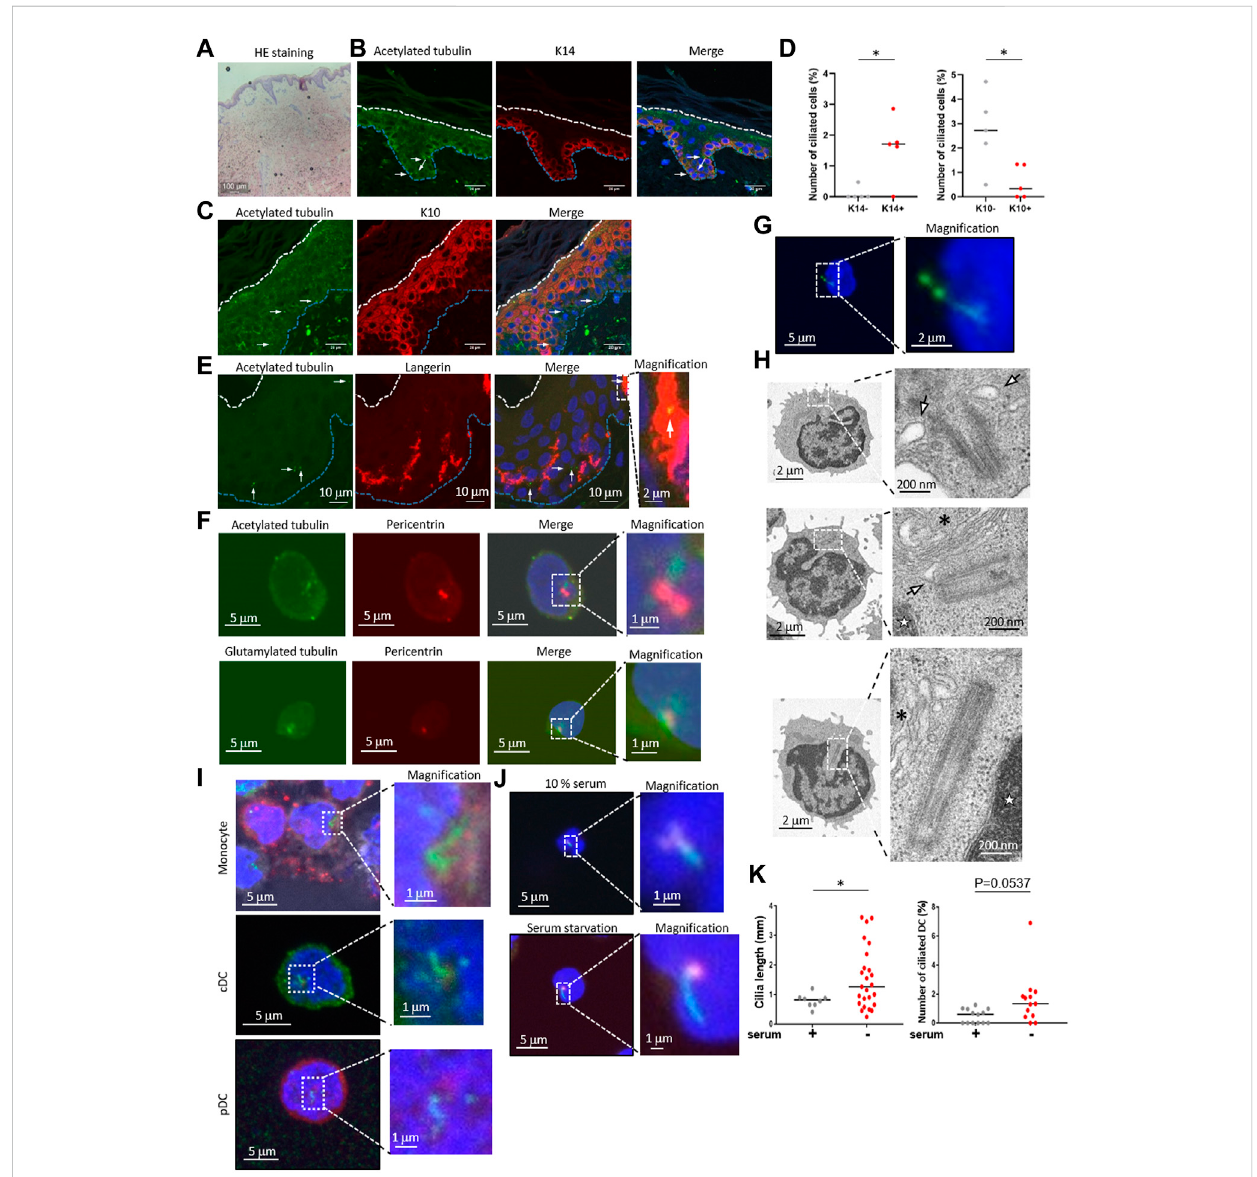
FIGURE 1 Humanprimary immune cellscanassembleprimary cilium-likestructures. (A) Hematoxylinandeosin(HE)stainingofhealthyhumanskin.Scalebar: 100 μ m. (B and C) Representative images of epidermal primary cilium-like structures (acetylated tubulin) in (B) theK14-positive basal layer, and in (C) the K10-positivestratumspinosum/granularlayer.Thearrowindicatestheprimarycilium.Thebluedottedlineindicatestheepidermalbasementmembrane. The white dotted line indicates the stratum corneum. Five biological replicates ( fi ve individual donors) were examined. Scale bars: 20 μ m. (D) The number of primary ciliated cells in the K14-positive basal layer and the K10-positive stratum spinosum/granular layer shown in Figures 1C,D. *, p < 0.05 (Mann-Whitney U test).n=5. (E) Representativeimmunostainingimageoflangerin-positiveLCsandprimarycilium (acetylatedtubulin)inhealthyhuman epidermis. The arrow indicates a primary cilium-like structure. The blue dotted line indicates the epidermal basement membrane. The white dotted line indicates the stratum corneum. The area within the dotted box was magni fi ed and shown on the right. Scale bars: 10 μ m and 2 μ m respectively. Five biological replicates ( fi ve individual donors) were examined respectively. (F) Representative immunostaining image of acetylated tubulin or glutamylated tubulin in human PBMCs. The dotted box indicates the magni fi ed area shown on the far right. Scale bars: 5 μ m and 1 μ m respectively. Three biological replicates(3donors)wereexamined. (G) RepresentativeimmunostainingimageofhumanPBMCsexpressingArl13B-GFP.Cellswereelectroporatedwith an Arl13B-GFP expressionplasmid. Twodays after transfection, cells wereimmunostained byusing an anti-GFP antibody. The area within thedottedbox was magni fi ed and shown on the right. Scale bars: 5 μ m and 2 μ m respectively. Three biological replicates (3 donors) were examined. (H) Electron microscope images of primary cilium-like structures in PBMCs. The top two pictures show representative ciliary vesicle-like structures. The bottom picture shows centrosome elongation resembling axoneme extension. For electron microscope analysis, fi ve biological replicates ( fi ve donors) were examined.Thearrowindicatesaciliaryvesicle-likestructure.TheasteriskindicatestheGolgiapparatus.Thestarindicatesthenucleus.Theareawithinthe dotted box was magni fi ed and shown on the right. Scale bars: 2 μ m and 200 nm respectively. (I) Monocytes, pDCs and cDCs were isolated from human PBMCs using fl ow cytometry, then cells were immunostainedwith acetylated tubulin(green), and pericentrin (red). Three biological replicates (3 donors) were examined. The area within the dotted box was magni fi ed and shown on the right. Scale bars: 5 μ m and 1 μ m respectively. (J) Human cDCs isolated fromPBMCswithmagneticbeadswereculturedinmediasupplementedwith10%FBSor0.5%FBS(serumstarvation)for16 h.Cellswereimmunostained with acetylatedtubulin(green) and pericentrin (red). Serum+; 1772 cells were observed and 8 cilia were identi fi ed. Serum-; 1829 cells were observed and 25 cilia were identi fi ed. (K) The number of primary ciliated cDCs and the cilium length shown in Figures 1J were measured. Thirteen biological replicates (13 donors) were examined respectively. The bar indicates the median value. *, p < 0.05 (Mann-Whitney U